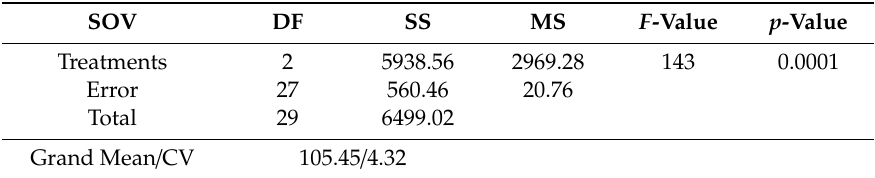
Table A3. Di ff erences of M. persicae number after 10 days in PeBL1-treated, bu ff er, and control cucumber seedlings.